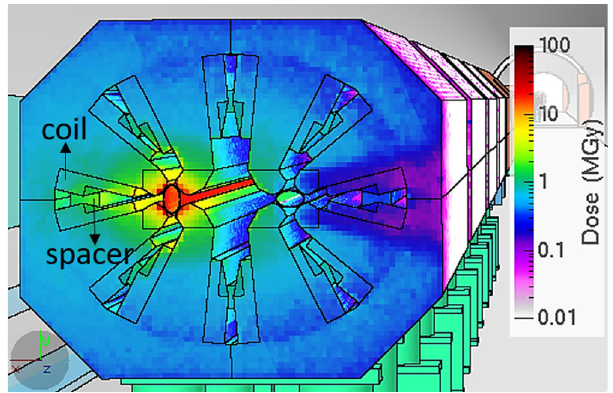
FIG. 10. Dose distribution on the MQWV.F5L for a cumulative loss of 10 16 top energy protons per beam on the collimation